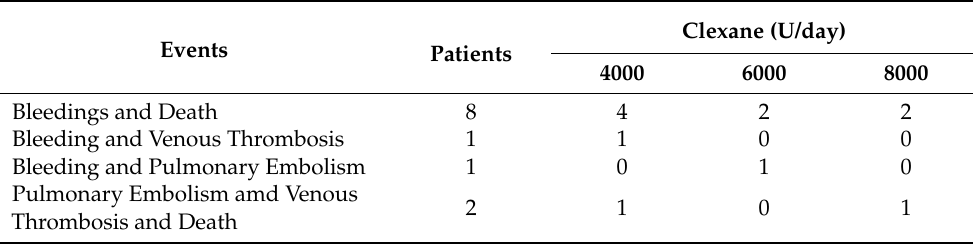
Table 3. Distribution of thrombotic and/or haemorragic events in different subgroup of the analyzed cohort of inpatients with